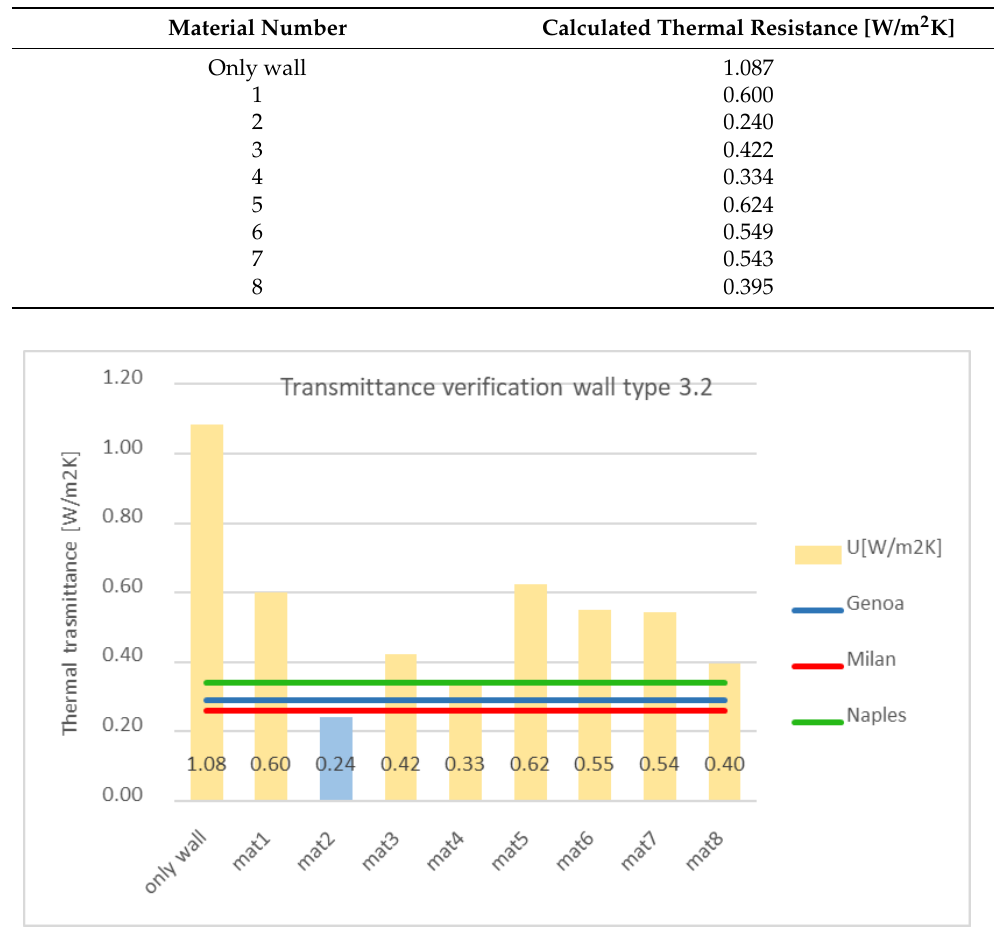
Figure A8. Wall type 3.2: transmittance check for the three main Italian climatic zones. In are blue the heat-reflective materials which respect all the limits.